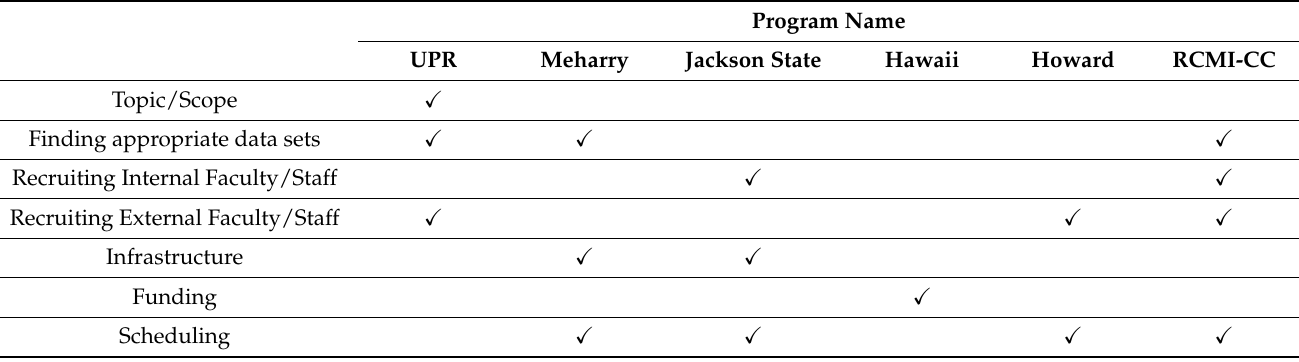
Table 8. Summary of challenges faced designing and implementing programming.